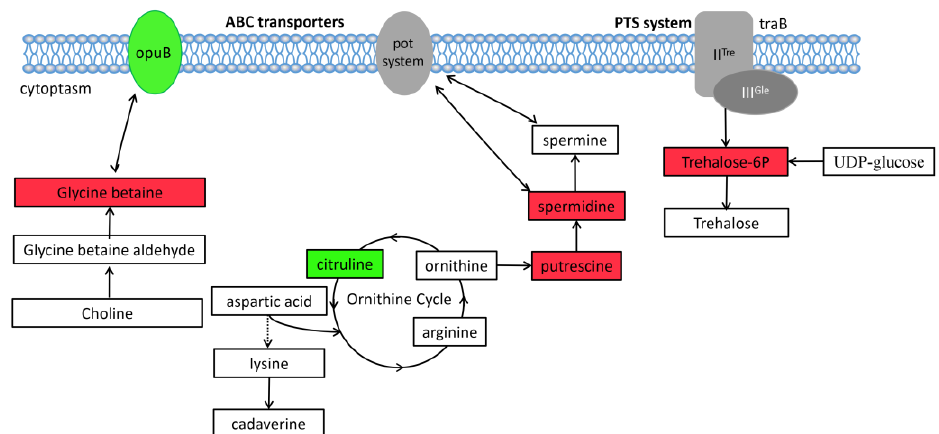
Figure 8. Membrane transport pathways based on multi-omics analysis of heat-resistance in RS047- wl. Colored rectangles are the relative content changes of metabolites in RS047-wl compared to WT RS047 (red, higher content; green, lower content; white, no significant change); ovals represent the transmembrane transport system in RS047-wl compared to WT RS047 (green, significantly lower content; white, no significant change).